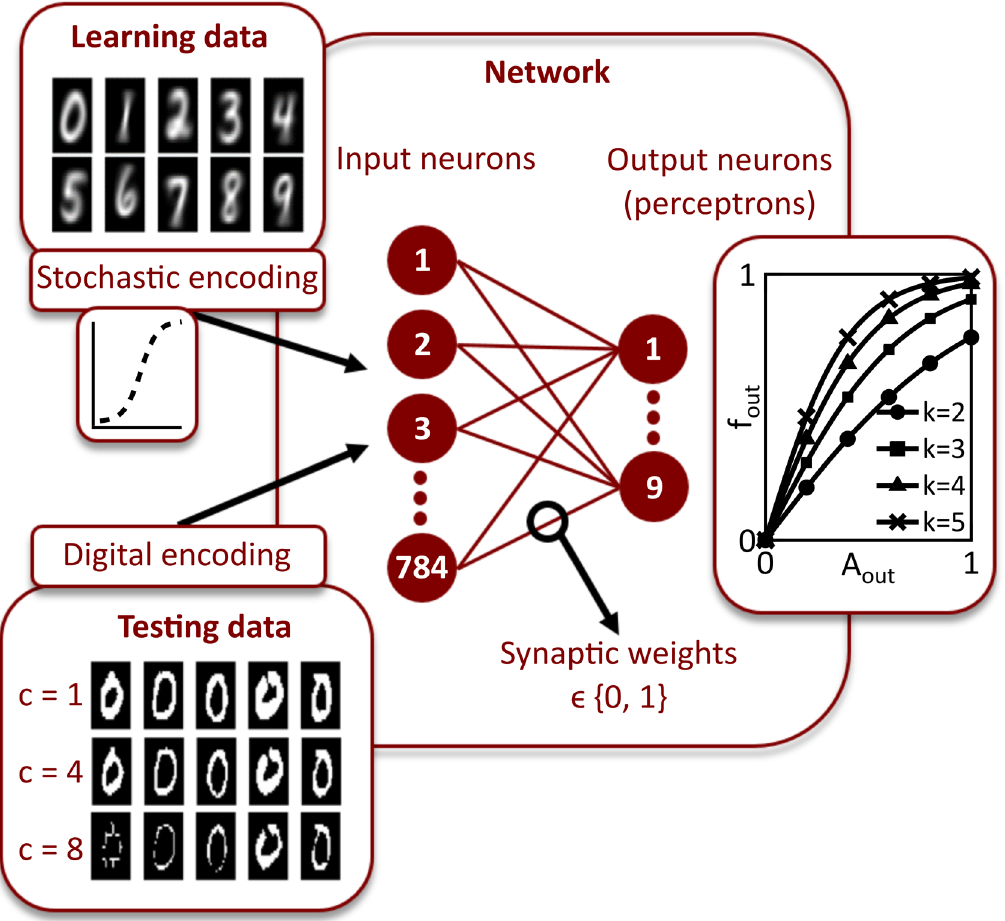
Figure 2. Schematic illustration of the network structure. Each learning data is the average of 100 images from the MNIST data base. The testing data are digitised from the MNIST test data base according to Eq. (5). For learning, the input neurons encode the pixel intensity into a switching probability of the correspondent synaptic weights according to a supervised assignment of the patterns to the receptive fields of the output neurons. For testing, the input neurons map the digitised images to the receptive fields. The output neurons are perceptrons which get activated by the testing data assigning the test images to the respective patterns. The activation function [see Eq. (6)] is depicted for different slopes k